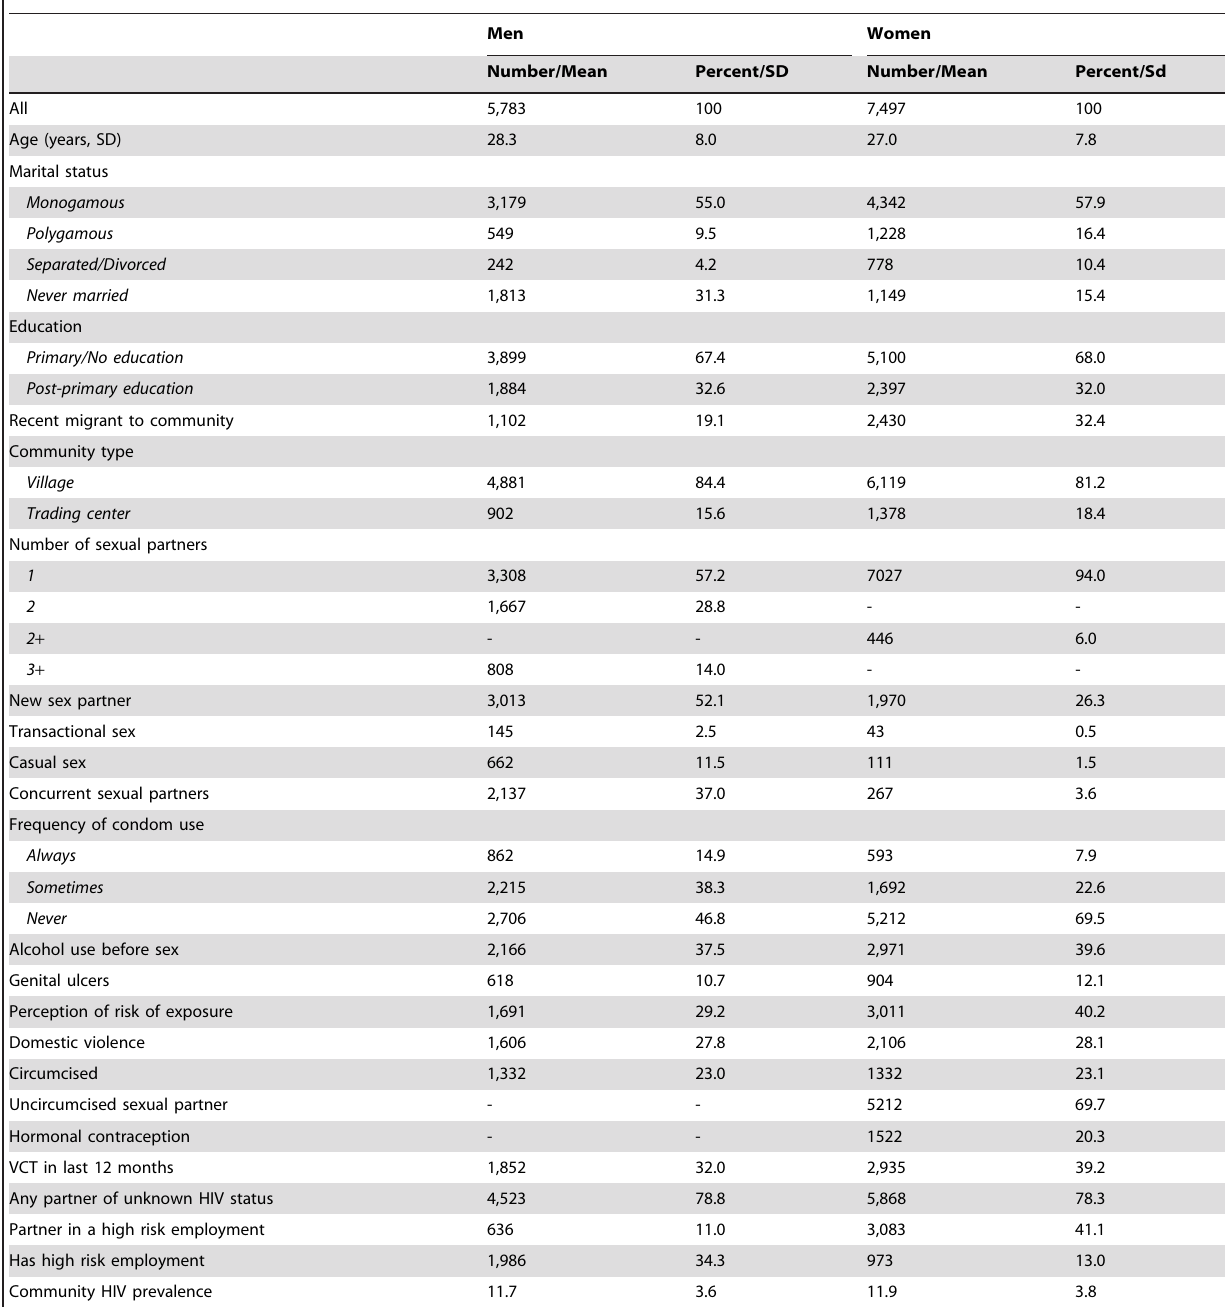
Table 2. Characteristics of Sexually active Participants, Rakai Cohort, 2003–2011.